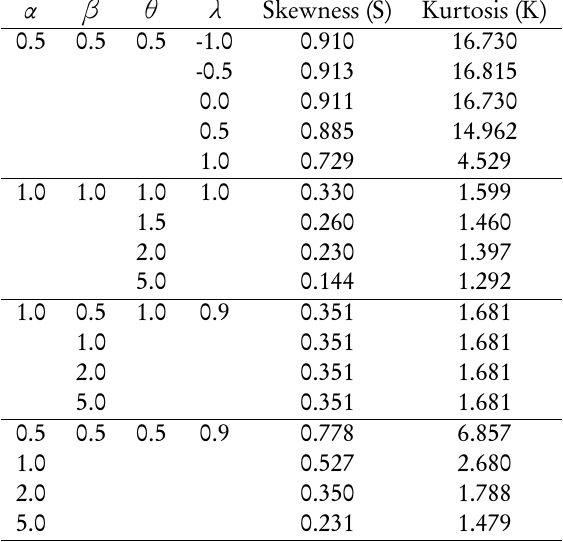
Measures of skewness and kurtosis of ETF distribution for given parameter